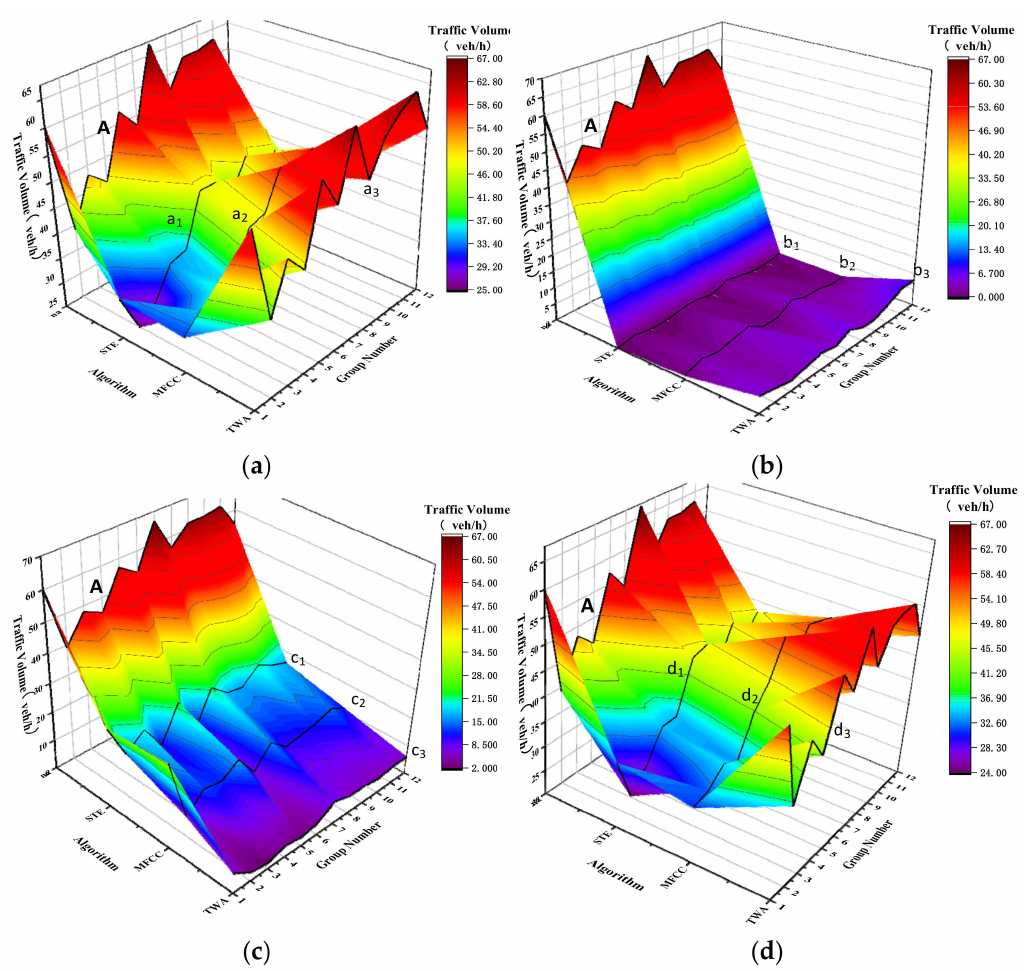
Figure 13. Analysis diagram of detection results of different algorithms. ( a ) n t comparison, ( b ) n ( t,w ) comparison, ( c ) n m comparison and ( d ) n ( t,c )